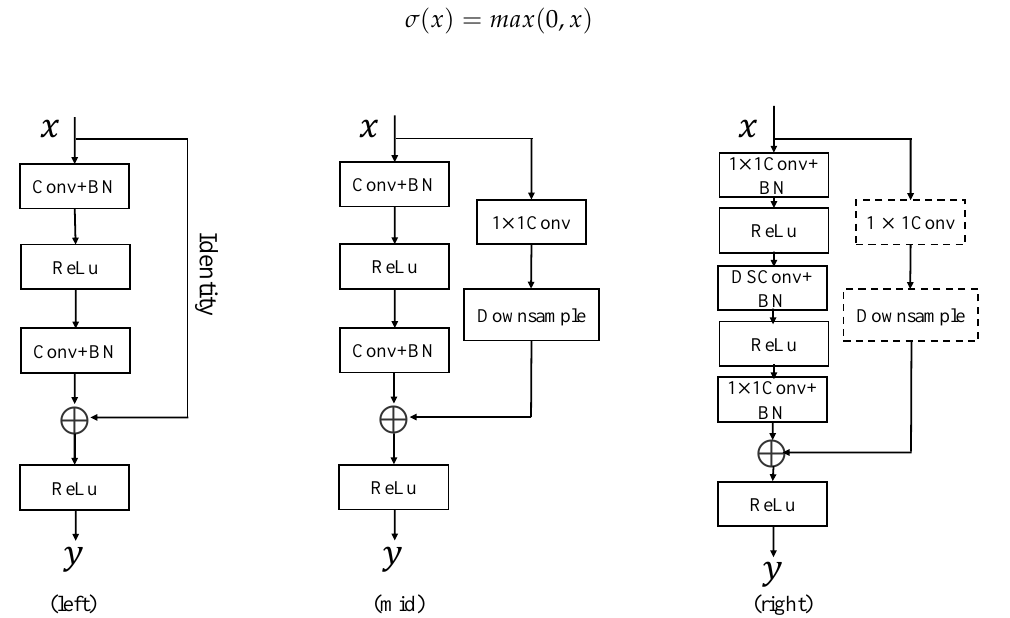
Figure 4. The structure of the residual learning module. ( left ) is a typical residual learning module, ( mid ) is a residual learning module commonly used in the encoder stage, and ( right ) is the residual learning module used in our